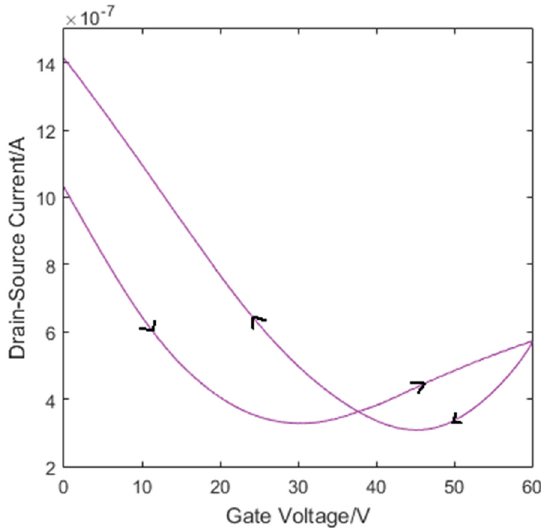
Figure 15. Optical micrograph of ( a ) an individual domain of mm sized CVD grown single layer graphene on Cu and ( b ) bilayer graphene on SiO 2 /Si substrates.